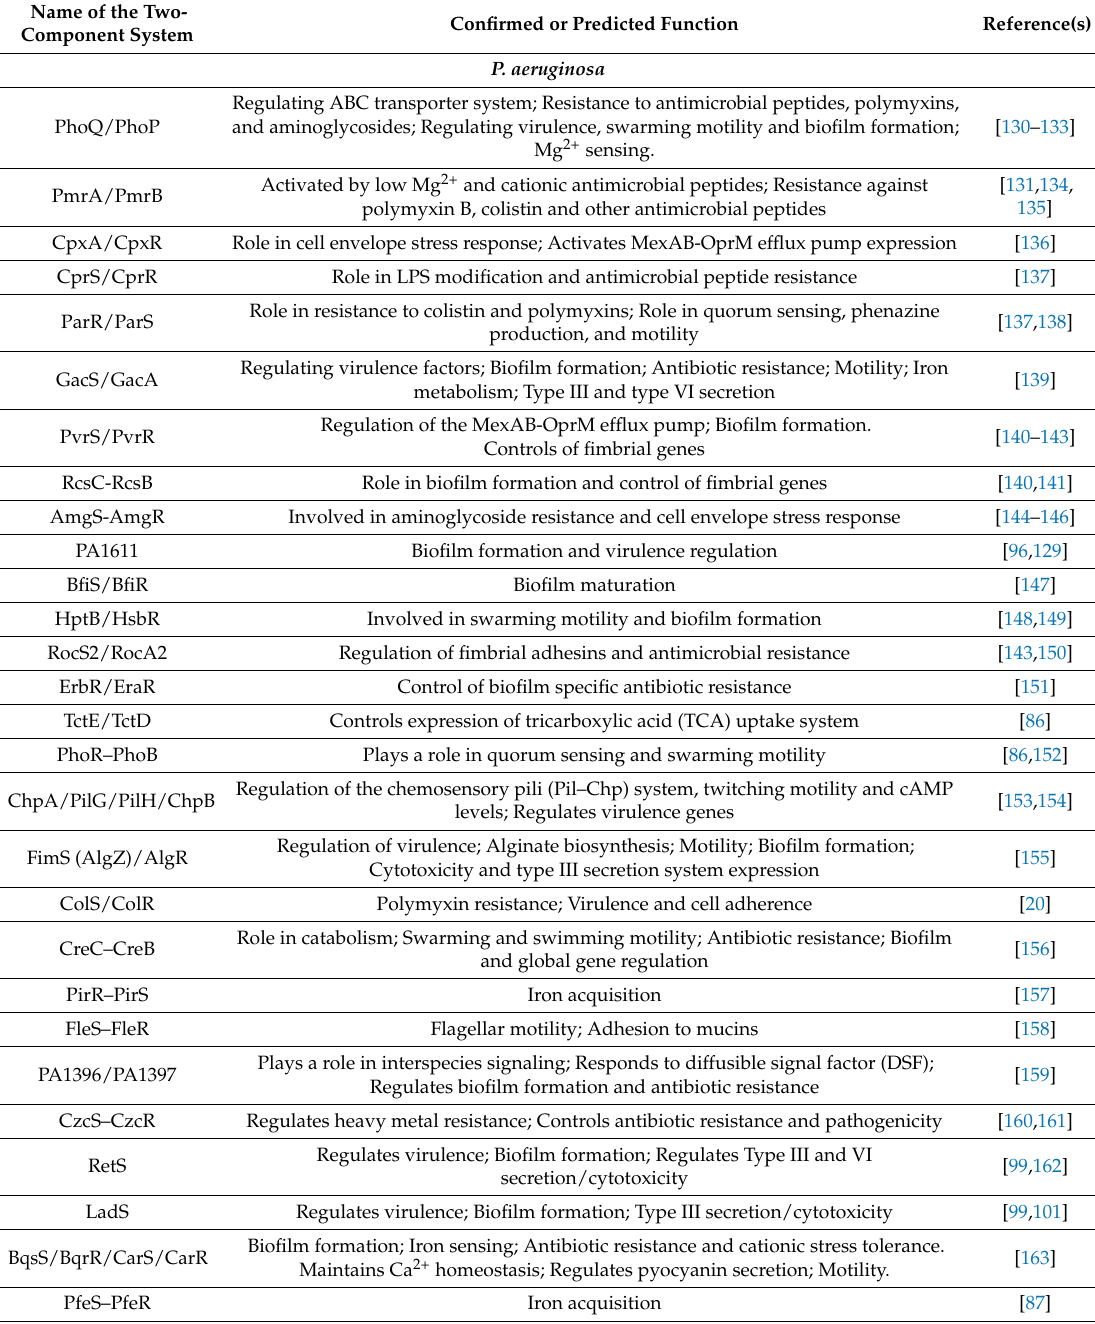
Table 1. Key TCSs that are reportedly or potentially associated with virulence and/or antibiotics resistance in P. aeruginosa , A. baumannii and K. pneumoniae